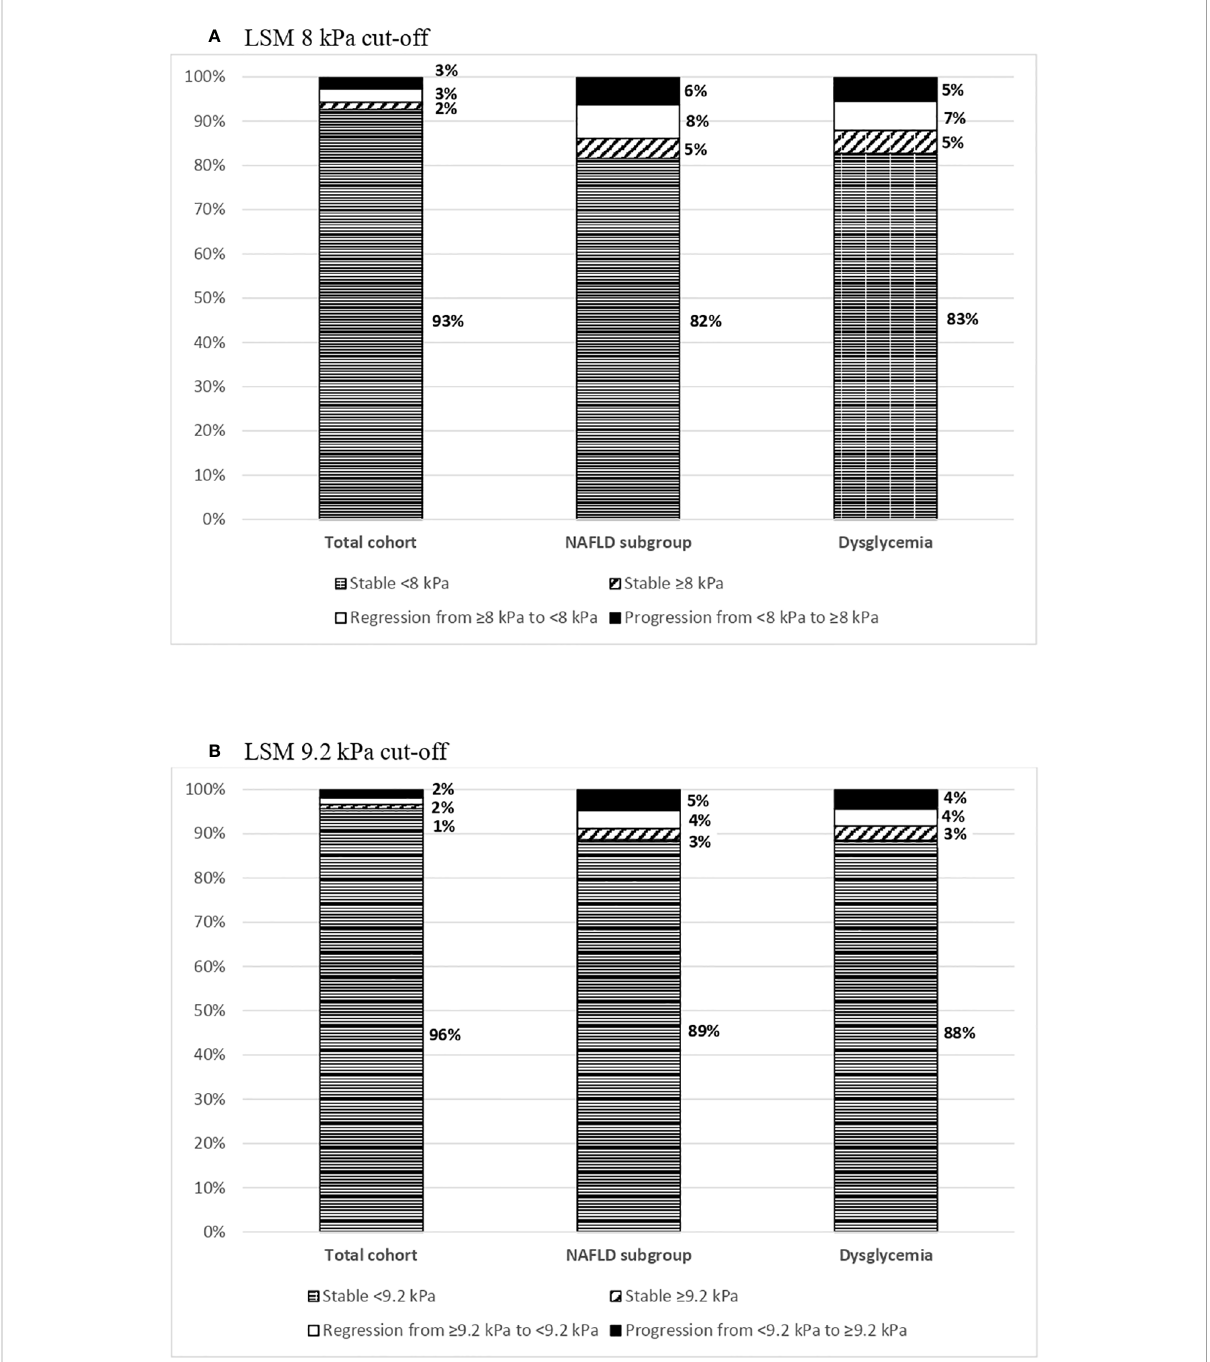
FIGURE 1 Categorical changes in longitudinal LSM by stage at follow up. (A) Percentage of subjects who maintained stable, regressed or progressed LSM during the follow-up period for the LSM 8 kPa cut-off. The total cohort, the NAFLD subgroup and the dysglycemia subgroup are represented in bars. To consider a change, a minimum increase/decrease of 1 kPa was required. (B) Percentage of subjects who maintained stable, regressed or progressed LSM during the follow-up period for the LSM 9.2 kPa cut-off. The total cohort, the NAFLD subgroup and the dysglycemia subgroup are represented in bars. To consider a change, a minimum increase/decrease of 1 kPa was